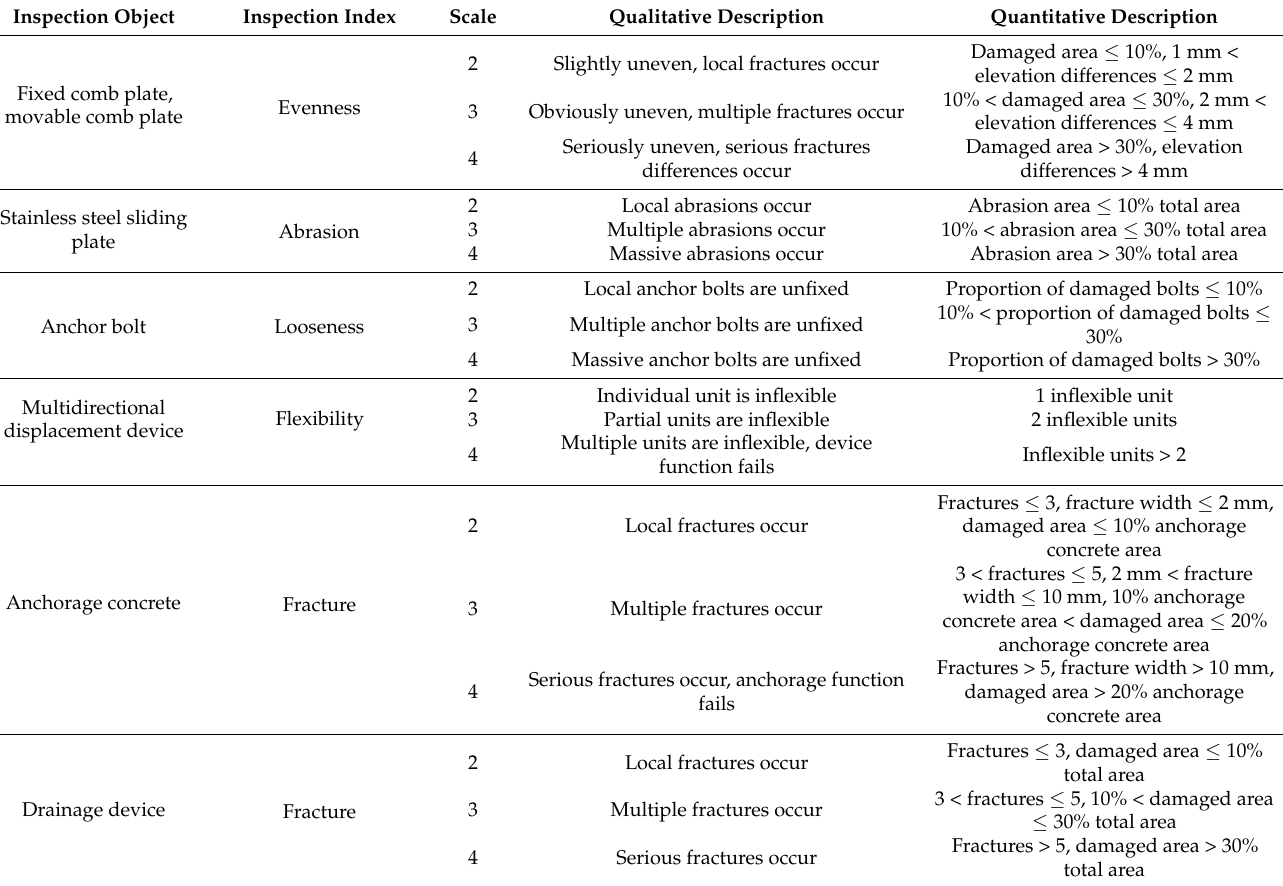
Table 5. Inspection index evaluation of the BECI of SSA, SSB comb plate type.